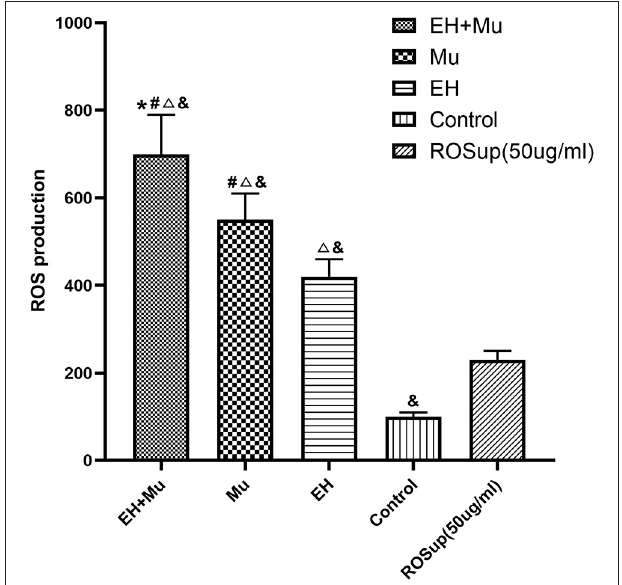
FIGURE 6 | Comparison of ROS produced by cells in each group. The elevated ROS production in groups carrying tRNA 15910 C > T mutation (* P < 0.05 vs. Mu group; # P < 0.05 vs. EH group; 1 P < 0.05 vs. control group; & P < 0.05 vs. ROSup [50 µ g/mL]).